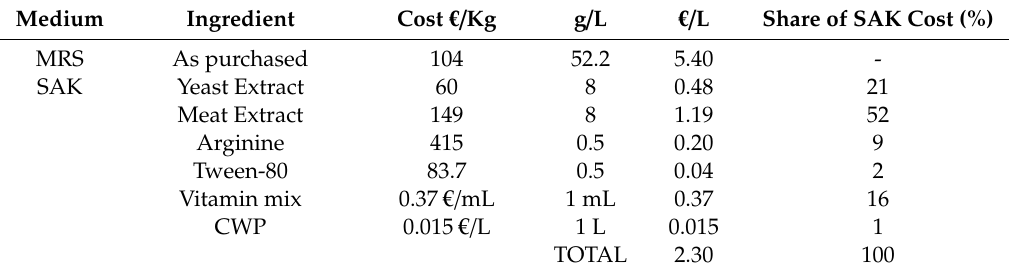
Table 1. Ingredients cost of MRS (benchmark) and SAK culture media (lab scale).